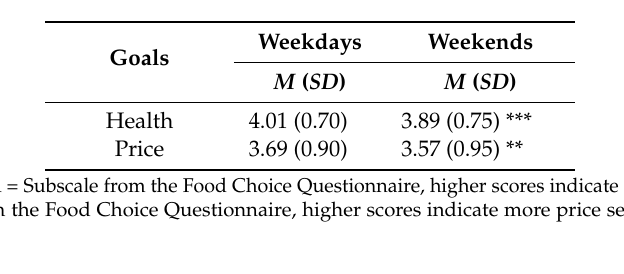
Table 4. Mothers’ Feeding Goals on Weekdays and